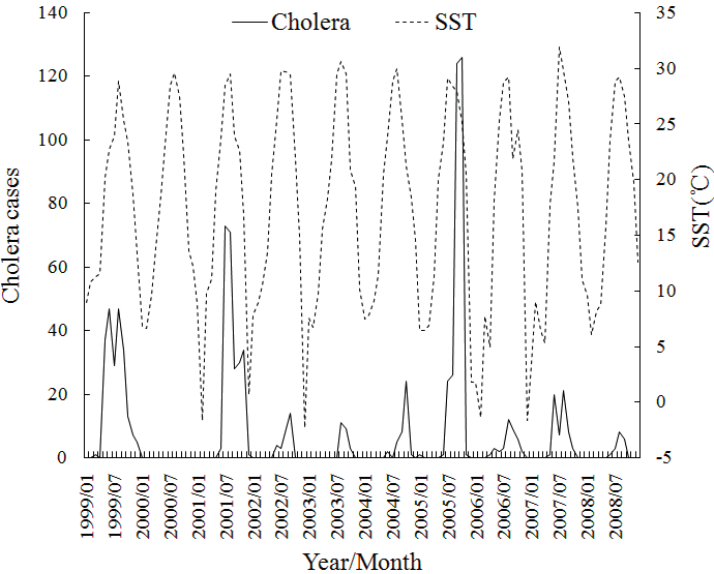
Figure 4. Time series of Monthly cholera cases and SST in Zhejiang, China during 1999–2008.